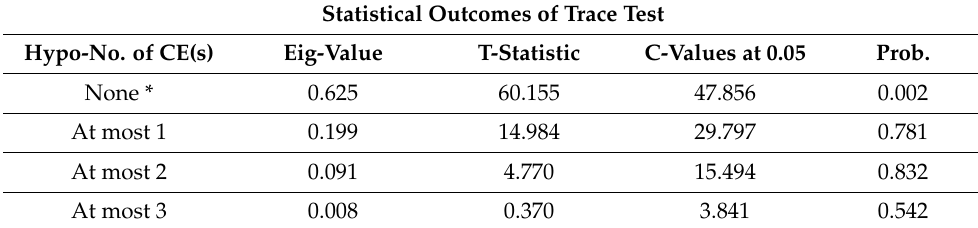
Table 3. Cointegration testing